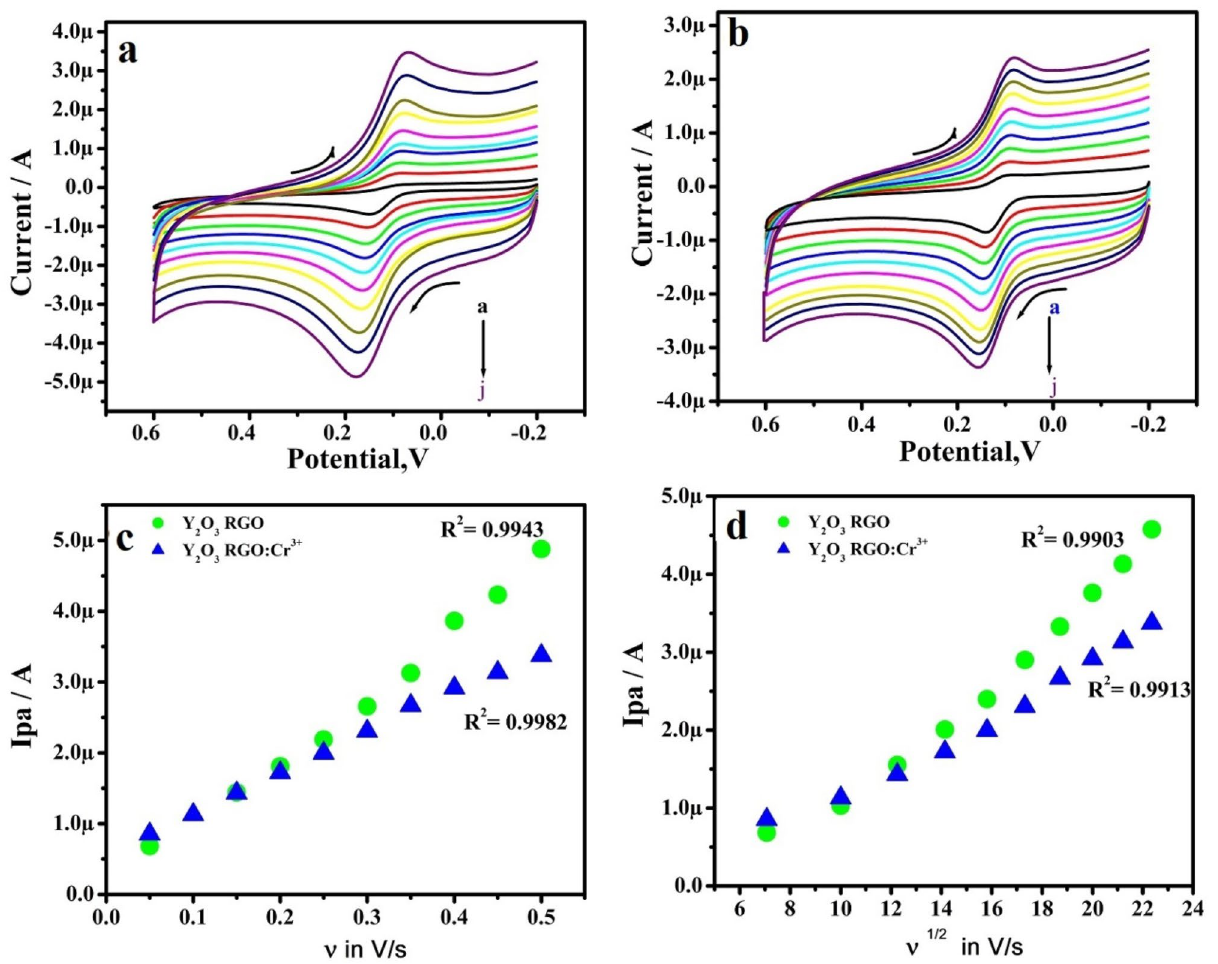
Figure 6. (a) CVs of 10 μM DA (0.2 M PBS of pH 7.4) at RGO-Y 2 O 3 MCPE at various scan rate ( b) CVs of 10 μM DA (0.2 M PBS of pH 7.4) at RGO-Y 2 O 3 ; Cr 3+ MCPE at various scan rate. ( c) Plot of Ipa versus υ. ( d) Plot of Ipa versus υ 1/2 .